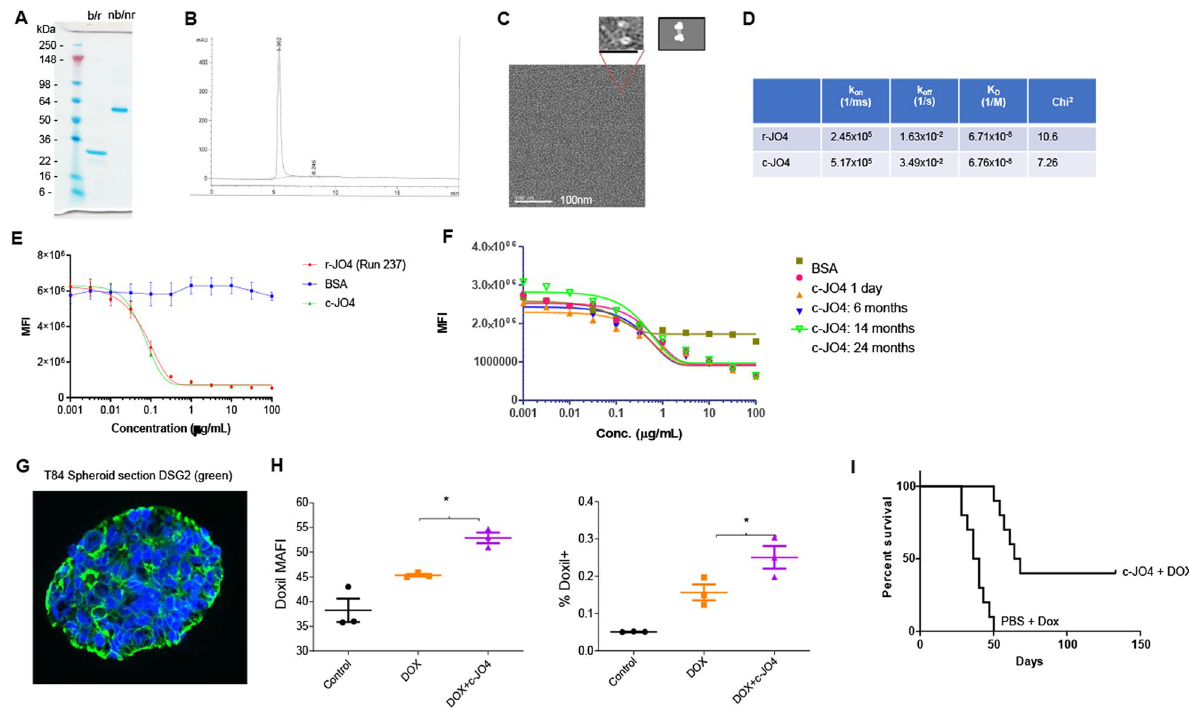
Figure 1. Characterization of c-JO4. ( A ) Polyacrylamide gel electrophoresis. Gennova’s preparation of JO4 (c-JO4) was treated as indicated. b/r—boiled and reduced; nb/nr—not boiled and not reduced. 1 μg protein was run on the gel. ( B ) Size exclusion chromatography (SEC) profile of c-JO4 run through a Superdex 200 increase 10/300 column with TBS. ( C ) Electron microscopy of c-JO4 negative staining with sodium silicotungstate. The zoomed in image showed a dimer of trimeric fiber knob domains. A schematic illustration of this structure is shown on the right. ( D ) Surface Plasmon Resonance analysis of JO4 binding to recombinant DSG2. DSG2 was immobilized on sensorchips, and background was automatically subtracted from the control flow cell. r-JO4 and c-JO4 were injected for 3 min at 2.5 μg/ml, followed by a 2.5-min dissociation period. Shown is the summary of SPR data. Parameters were evaluated using BIAeval software. k on - association rate; k off —dissociation rate; K D —equilibrium dissociation constant; chi 2 —area of the squared difference between the measured data point and the fit. ( E – I ) Potency assays. ( E ) Ad3-GFP Infection competition. Research r-JO4 run (#237) was compared with c-JO4. 293 cells were incubated in 96-well plates with JO4 proteins at indicated concentrations for 1 h before addition of Ad3-GFP virus for competition. GFP expression was measured 18 h after virus addition to measure extent of JO4 competition with Ad3-GFP. ( F ) c-JO4 was stored at 4 °C for 1 day (red dot), 6 months (orange triangle), 14 months (blue triangle), and 24 months (empty green triangle) and then tested in infection competition assay. ( G,H ) c-JO4-enhanced Doxil penetration in epithelial tumor spheroids. ( G ) Confocal immunofluorescence images of T84 spheroids stained for DSG2 (Green) and DAPI (blue). ( H ) Left panel: Uptake of liposomal doxorubicin (Doxil) (DOX) in T84 cell spheroids after treatment with c-JO4. The amount of Doxil (mean autofluorescence intensity—MAFI) in tumor cells was measured 1 h after adding it to tumor sphere cultures. Right panel: Doxil released from spheroids into the supernatant after trypsin digestion of spheroids. *p < 0.05. ( I ) c-JO4-enhanced anti-tumor activity. CB17 immunodeficient mice bearing epithelial tumors derived from T84 human colon adenocarcinoma cells were used for testing. When tumors reached a volume of 100 mm 3 , mice were intravenously injected with either PBS or c-JO4 (2 mg/kg) followed by Doxil (1 mg/kg) one hour later. Mice received three injection cycles 3 days apart. Tumor volumes were measured twice a week until reaching a tumor volume of 1000 mm 3 when they were sacrificed. The day of sacrifice served as the endpoint in Kaplan–Meier survival studies. In the c-JO4/Doxil group, tumor growth was significantly delayed (p < 0.0001) and 45% of the animals were still tumor-free at day 140 after tumor cell inoculation. N = 10. p < 0.001 for Doxil vs c-JO4 +